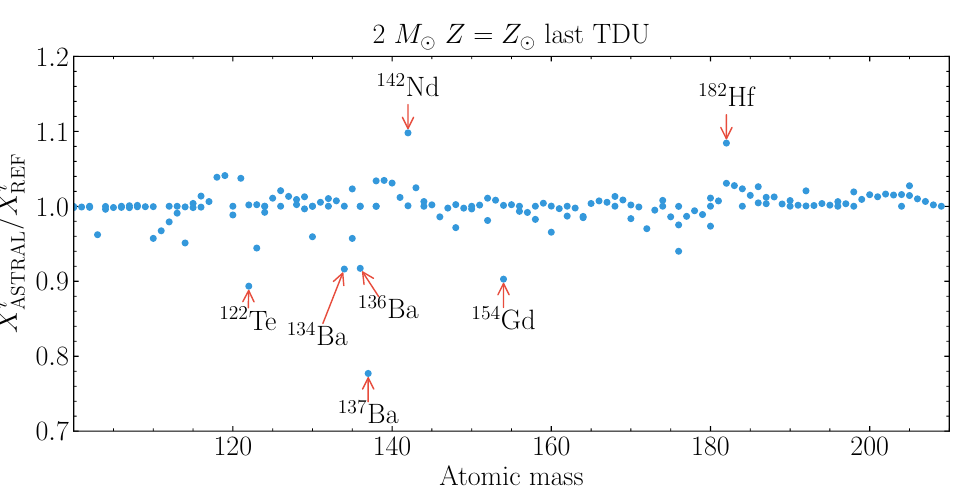
Figure 2. Same as Figure 1, but for a star with metallicity Z = Z . (cid:12) Z = 0.01 NEW model (see The above results are confirmed by the M = 2 M (cid:12) Figure 3), for which the higher neutron-to-seed ratio and temperatures attained during TPs cause a significant difference also for the 176 Hf abundance. 176 Hf and its parent 176 Lu are two s-only isotopes. 176 Lu was originally considered as a possible nuclear chronometer for the age of s-elements because of its long half-life. However, at temperatures typical of the s-process, it exhibits a quite strong dependency on temperature [46] due to the coupling between the short-lived isomer ( t m = 3.66 h) and the long-lived ground state 1/2 ( t g = 36 Gyr; see Söderlund et al. [47]). During the 13 C pocket phase the temperatures are 1/2 so low ( 80–100 MK) that the two states actually behave as separate nuclei, being internal ∼ transitions highly forbidden by nuclear selection rules. On the other hand, at the higher temperatures of the TPs, overlying mediating states are excited and can decay to the long- lived ground state as well (see, e.g., Heil et al. [48]). This increases the 176 Lu g production at the expense of 176 Hf, whose production is suppressed because of the enhanced (n, γ ) branch feeding 176 Lu. The production of 176 Lu g is then determined by the partial (n, γ ) cross section of the ground state 176 Lu g to the total cross section. In our models, this ratio is set to 0.20 for temperatures lower than 200 MK and 0.25 for higher temperatures (see Cristallo et al. [49]). The new ASTRAL v0 evaluations indicate that both the production and the destruction channels of the long-lived 176 Lu g are greater than the REF case (see Table 1). Moreover, the destruction cross section of 176 Hf is slightly larger. As a whole, the NEW model shows an abundance of 176 Hf reduced by 10% compared to the REF model. ∼ On the other hand, the 176 Lu/ 176 Hf ratio increases by ∼